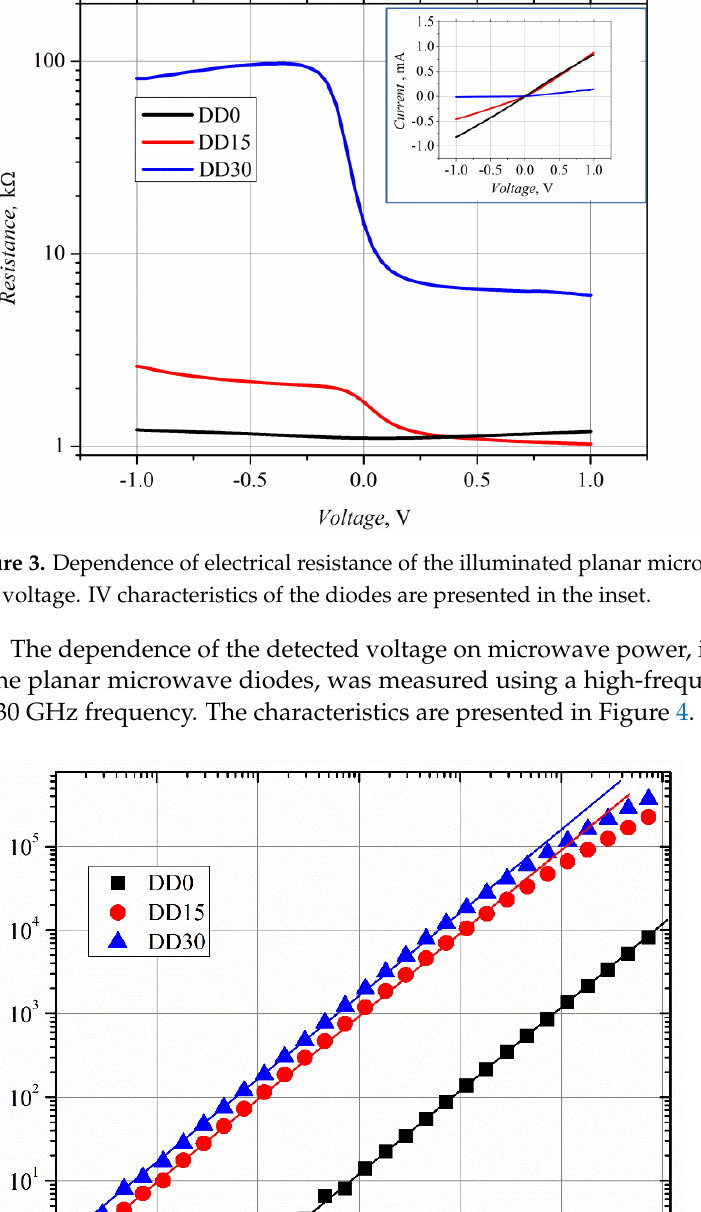
Figure 4. Voltage–power characteristics of the planar microwave diodes measured under white- light illumination at f = 30 GHz frequency. Lines are guides for the eye of linear dependence.